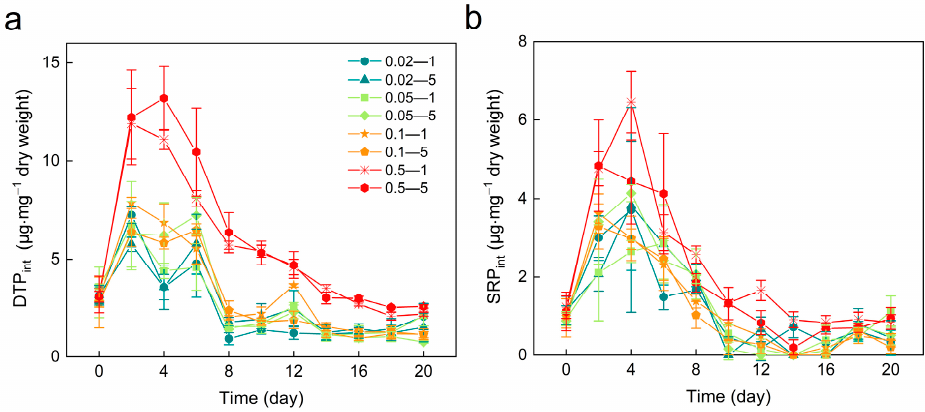
Figure 4. The changes in DTP int ( a ) and SRP int ( b ) of C. ovalisporum in the different treatments.